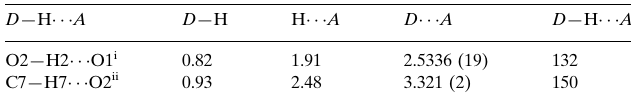
Hydrogen-bond geometry (A˚ , (cid:2)